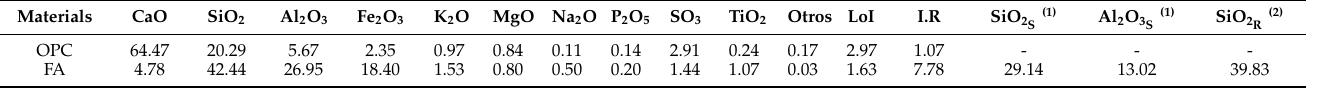
Table 1. OPC and FA chemical composition (wt%).